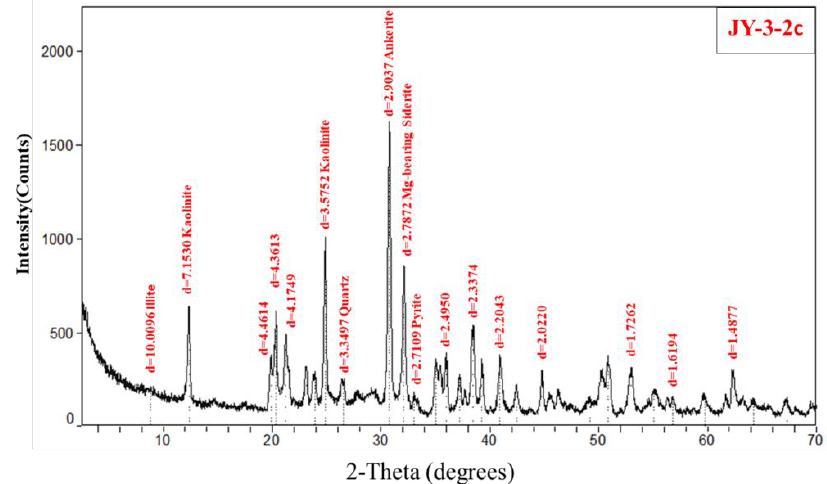
Figure 3. Identification of the well-ordered structure of kaolinite and siderite (contains Mg) in the X-ray diffractogram of sample JY-3-2c.